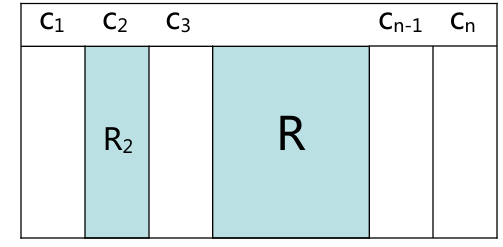
Figure 20 . Special case k R =0 of maximally constructing full cells from full cells.